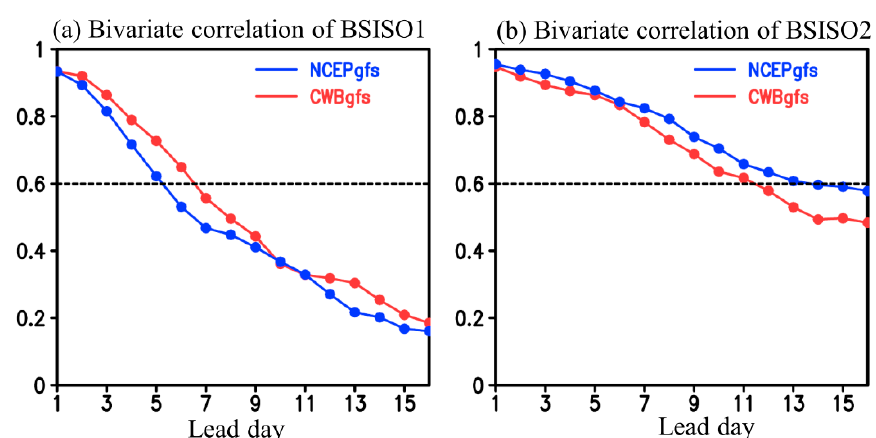
Figure 11. ( a ) Bivariate correlation coef fi cients for BSISO1 index during May and June 2017 forecasted by NCEPgfs (blue line) and CWBgfs (red line) at different lead times. ( b ) is similar to ( a ), but for the bivariate correlation coefficients of BSISO2 forecasted by NCEPgfs and CWBgfs.